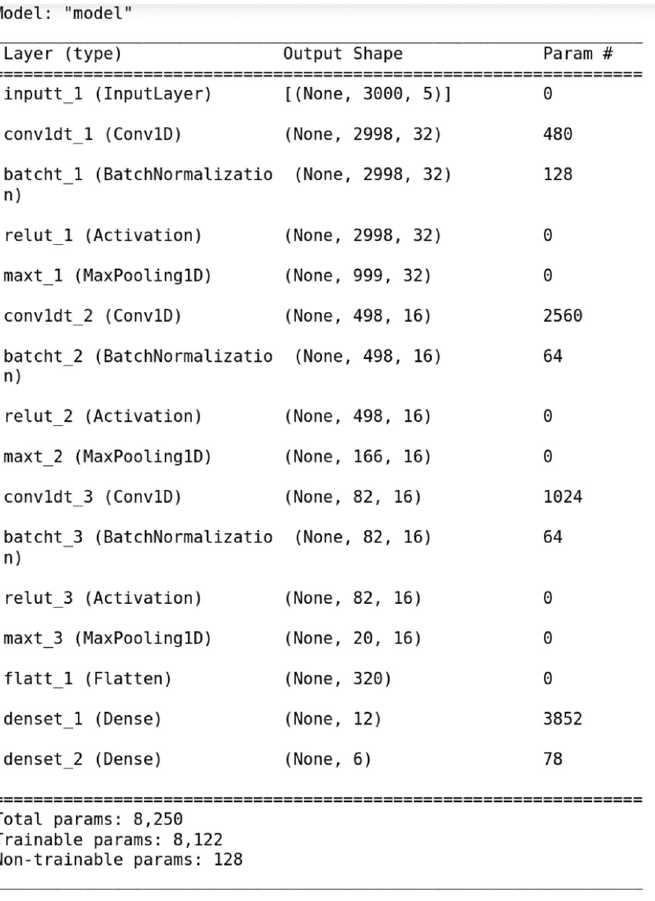
( f ) Figure 4. Maximal overlap discrete wavelet transform (MODWT) execution result. ( a ) Original signal, ( b ) level 1, ( c ) level 2, ( d ) level 3, ( e ) level 4, and ( f ) residual. 3. Artificial Intelligence Network